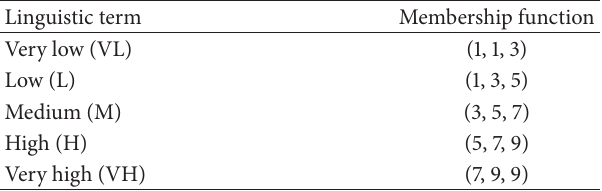
Table 3: Linguistic terms for criteria